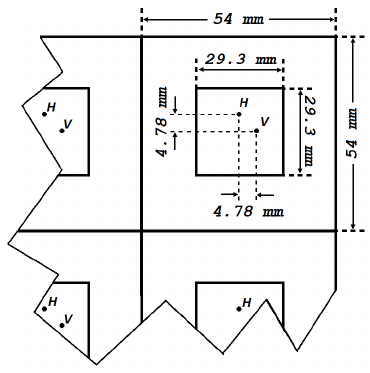
Figure 8. Specifications of the array antenna.